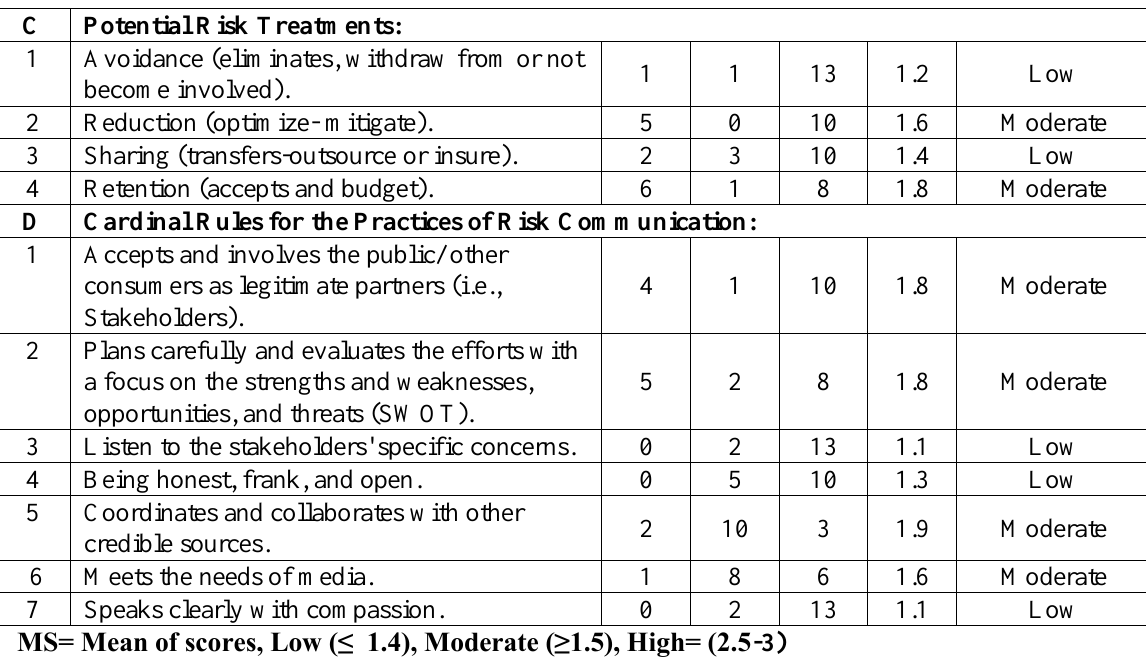
Table (3): Evaluation of Risk Management at Ordinary Primary Health Care Centers